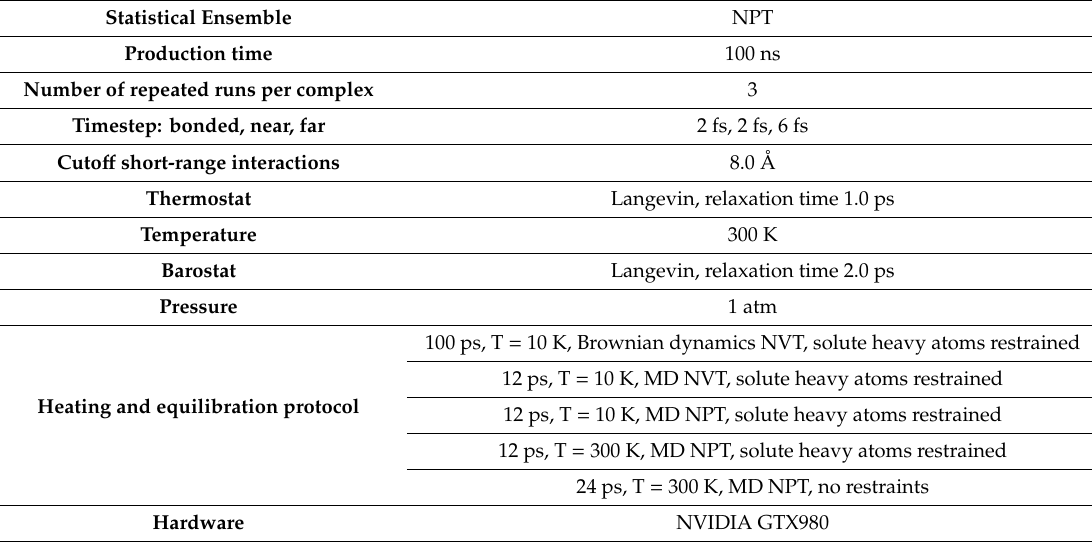
Table 3. MD simulation parameters and protocols used in this